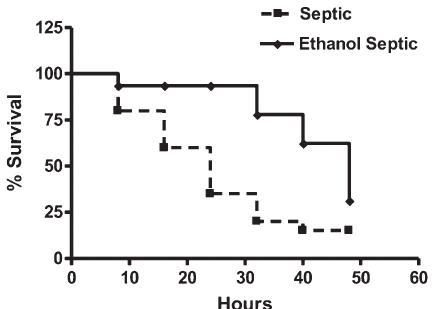
Figure 1. Ethanol consumption protects female rats against sepsis. The septic group (n=20) received water and the ethanol septic group (n=20) received 10% ethanol solution for 4 weeks. Animals in estrus phase were challenged with feces injected intraperitoneally at 48 h. P=0.0001, log rank